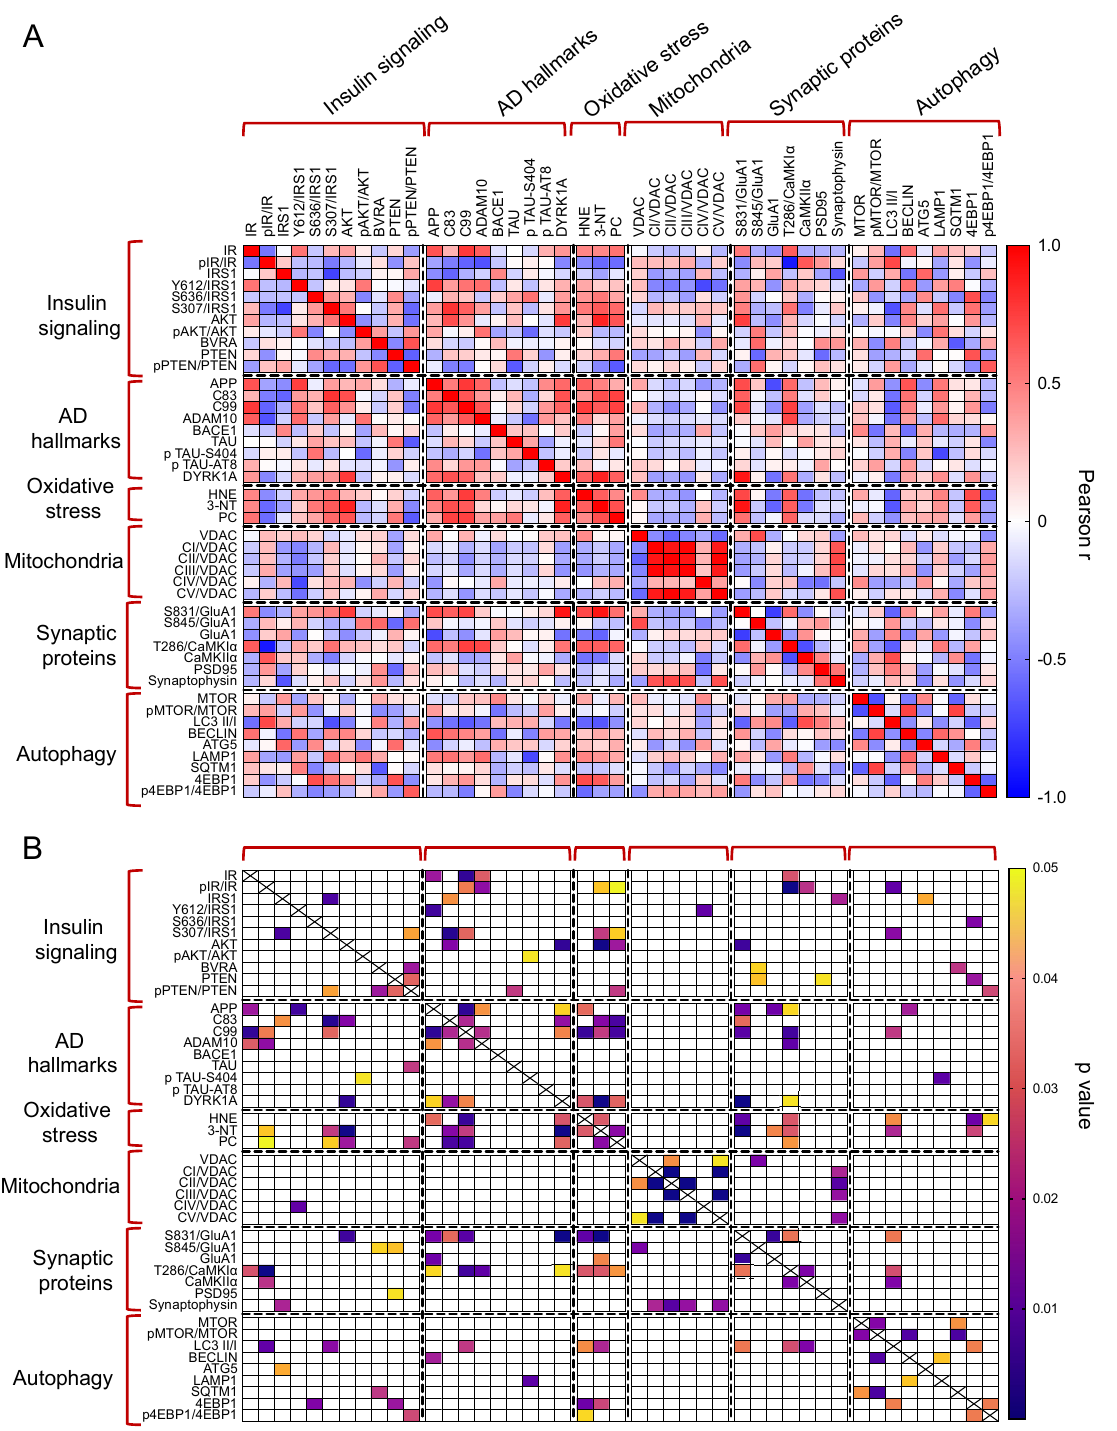
Figure 6. Correlation analyses. Pearson correlation analyses were performed to explore associations among all the proteins measured in in our work. Correlations are shown as correlation matrix. In ( A ) Pearson r values are reported. In ( B ) significant correlations are indicated.